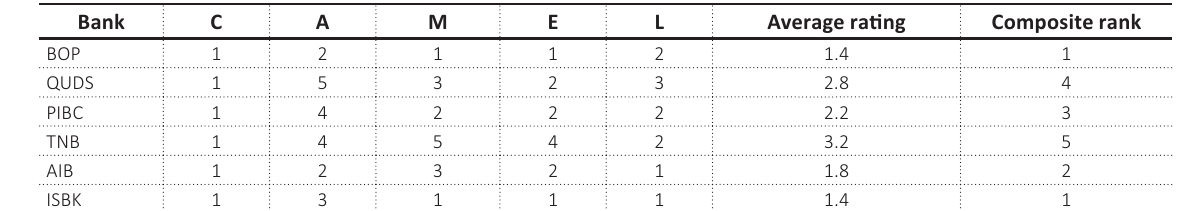
Table 10. Composite rating based on the CAMEL rating system